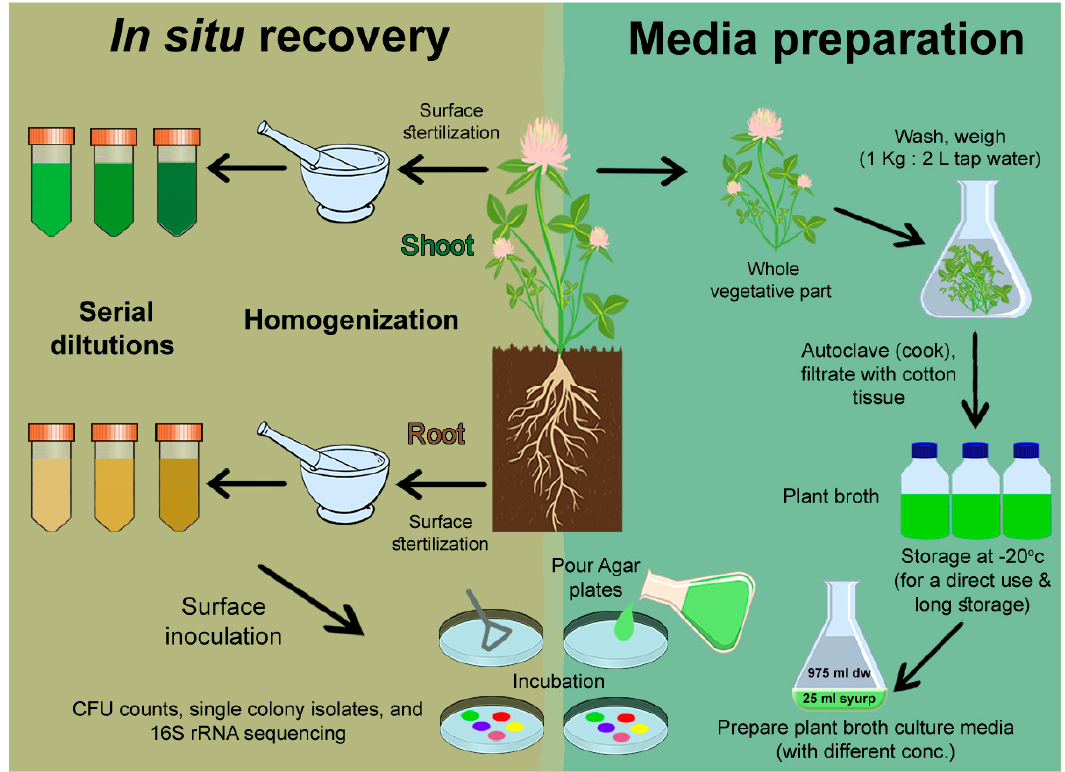
Figure 1. A workflow of in situ recovery and analysis of bacterial communities residing in the endo ‐ rhizosphere and endo ‐ phyllosphere of tested plants and plant broth culture media preparation.